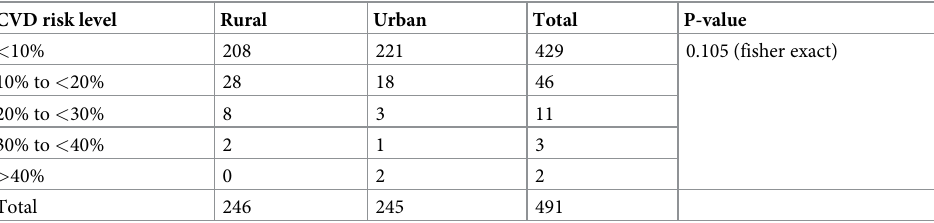
Table 3. Distribution of cardiovascular risk level in the rural and urban